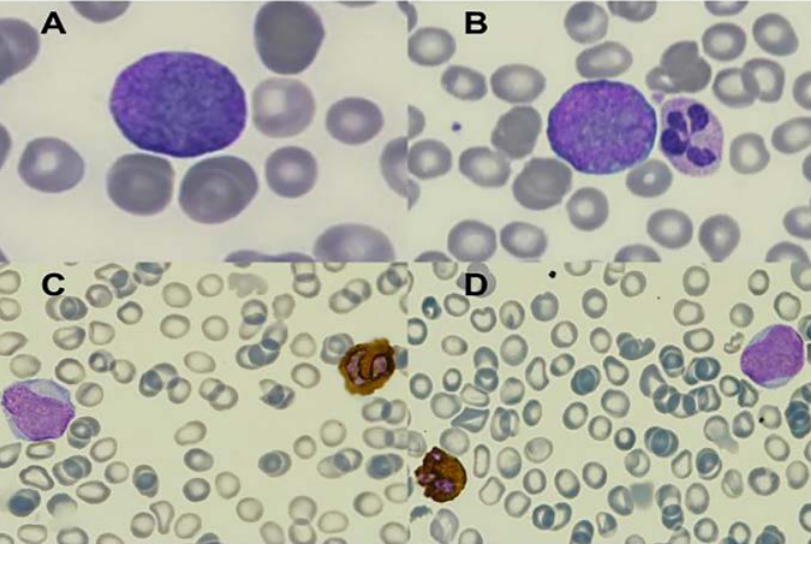
Figure 1. Morphology of peripheral blood (A) and bone marrow (from aspirate, B) sam- ples. May-Grunwald-Giemsa staining shows blast-like morphology of neoplastic lympho-